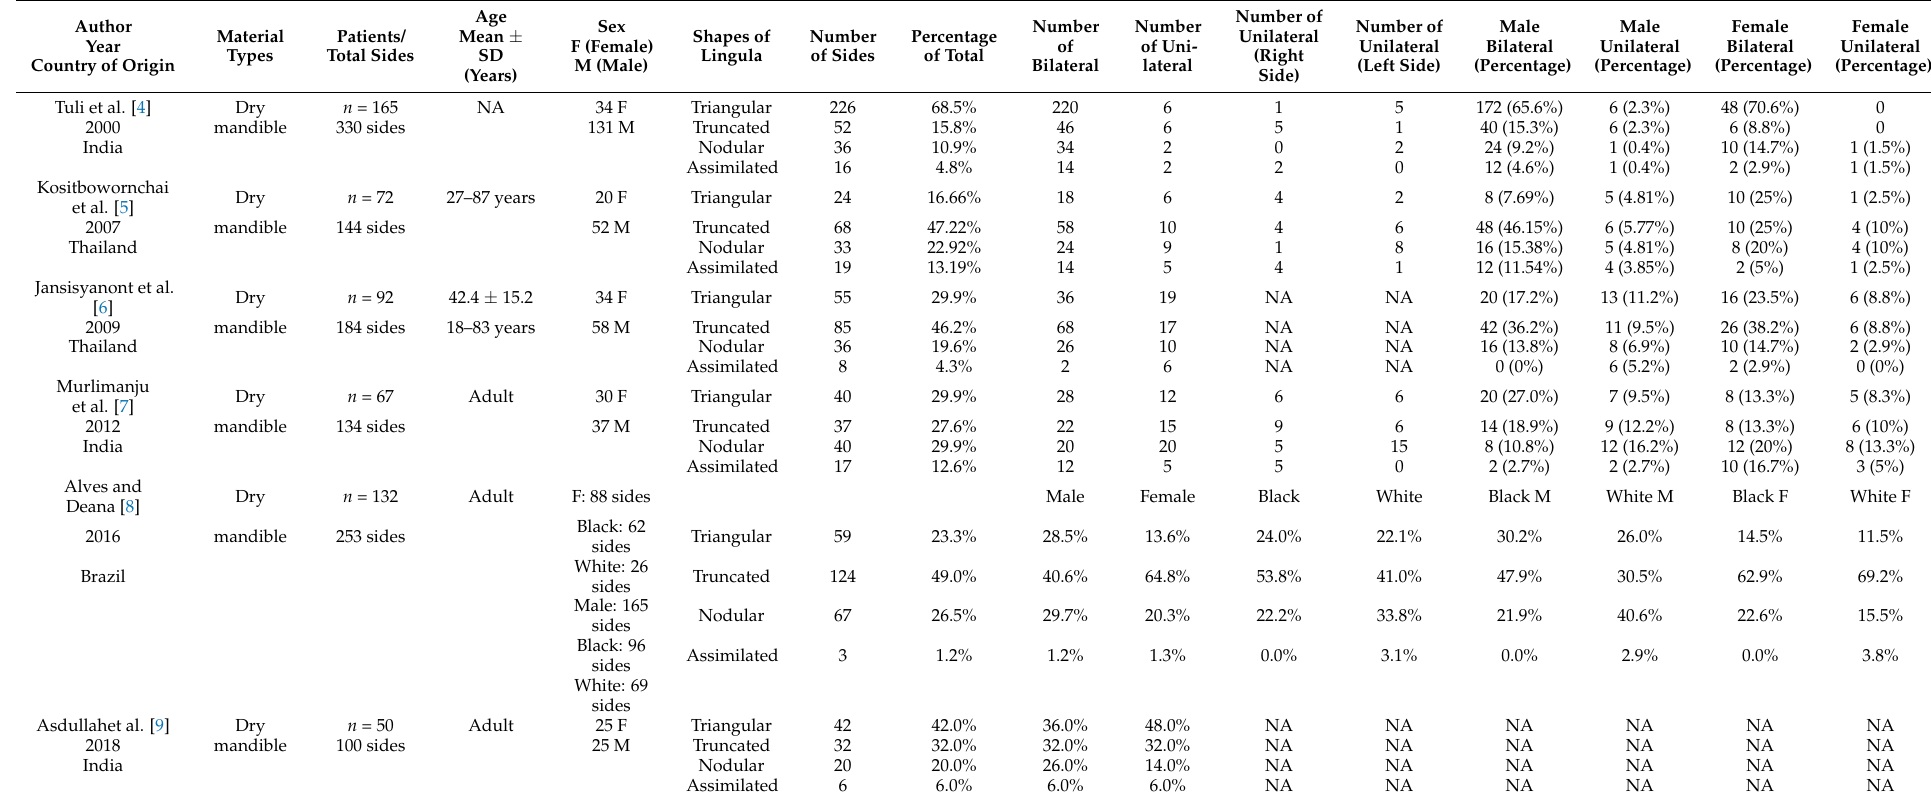
Table 1. Demographic and study characteristics in the included studies (Dry